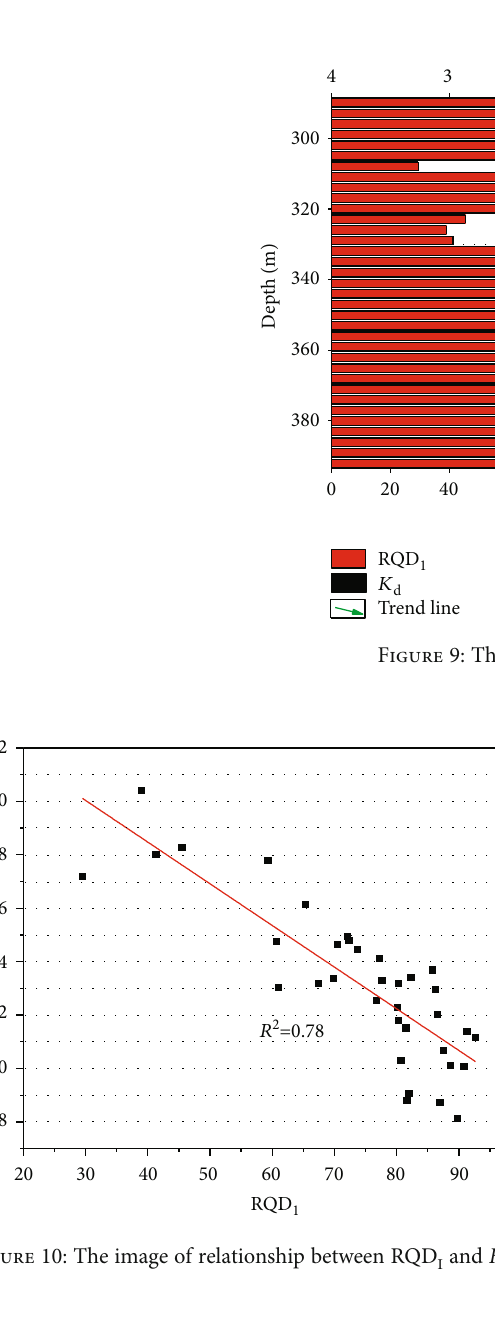
Figure 10: The image of relationship between RQD